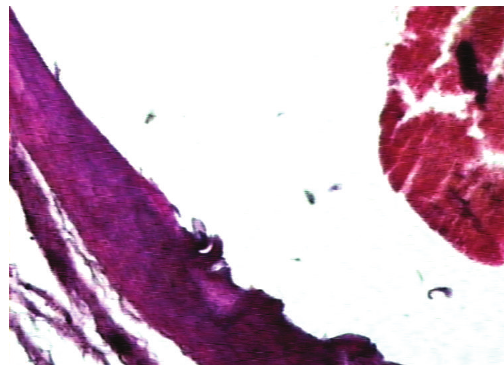
Figure 3: Severed endothelium in the territory of a pontine artery (center of the figure) with fragments of a fresh thrombus (right in the figure).